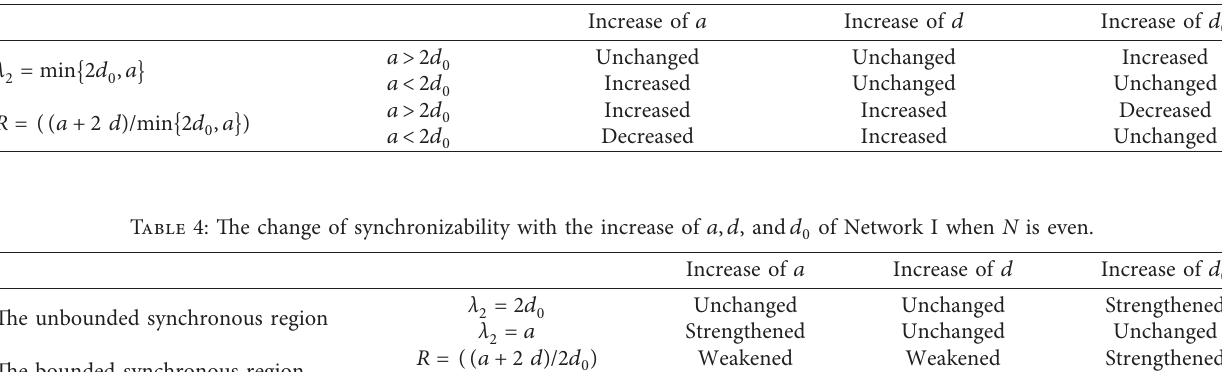
of Network I when N is even. 0